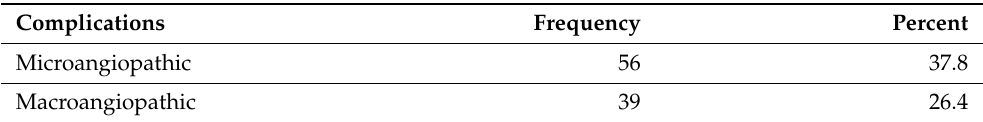
Table 3. Frequency of diabetes complications in the studied